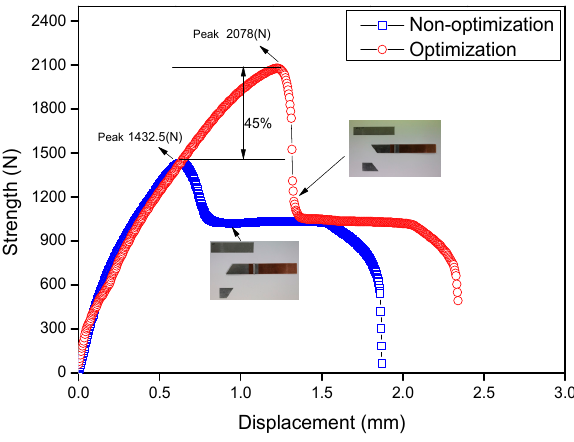
Figure 14. Comparison strength between non-optimized and optimized conditions.